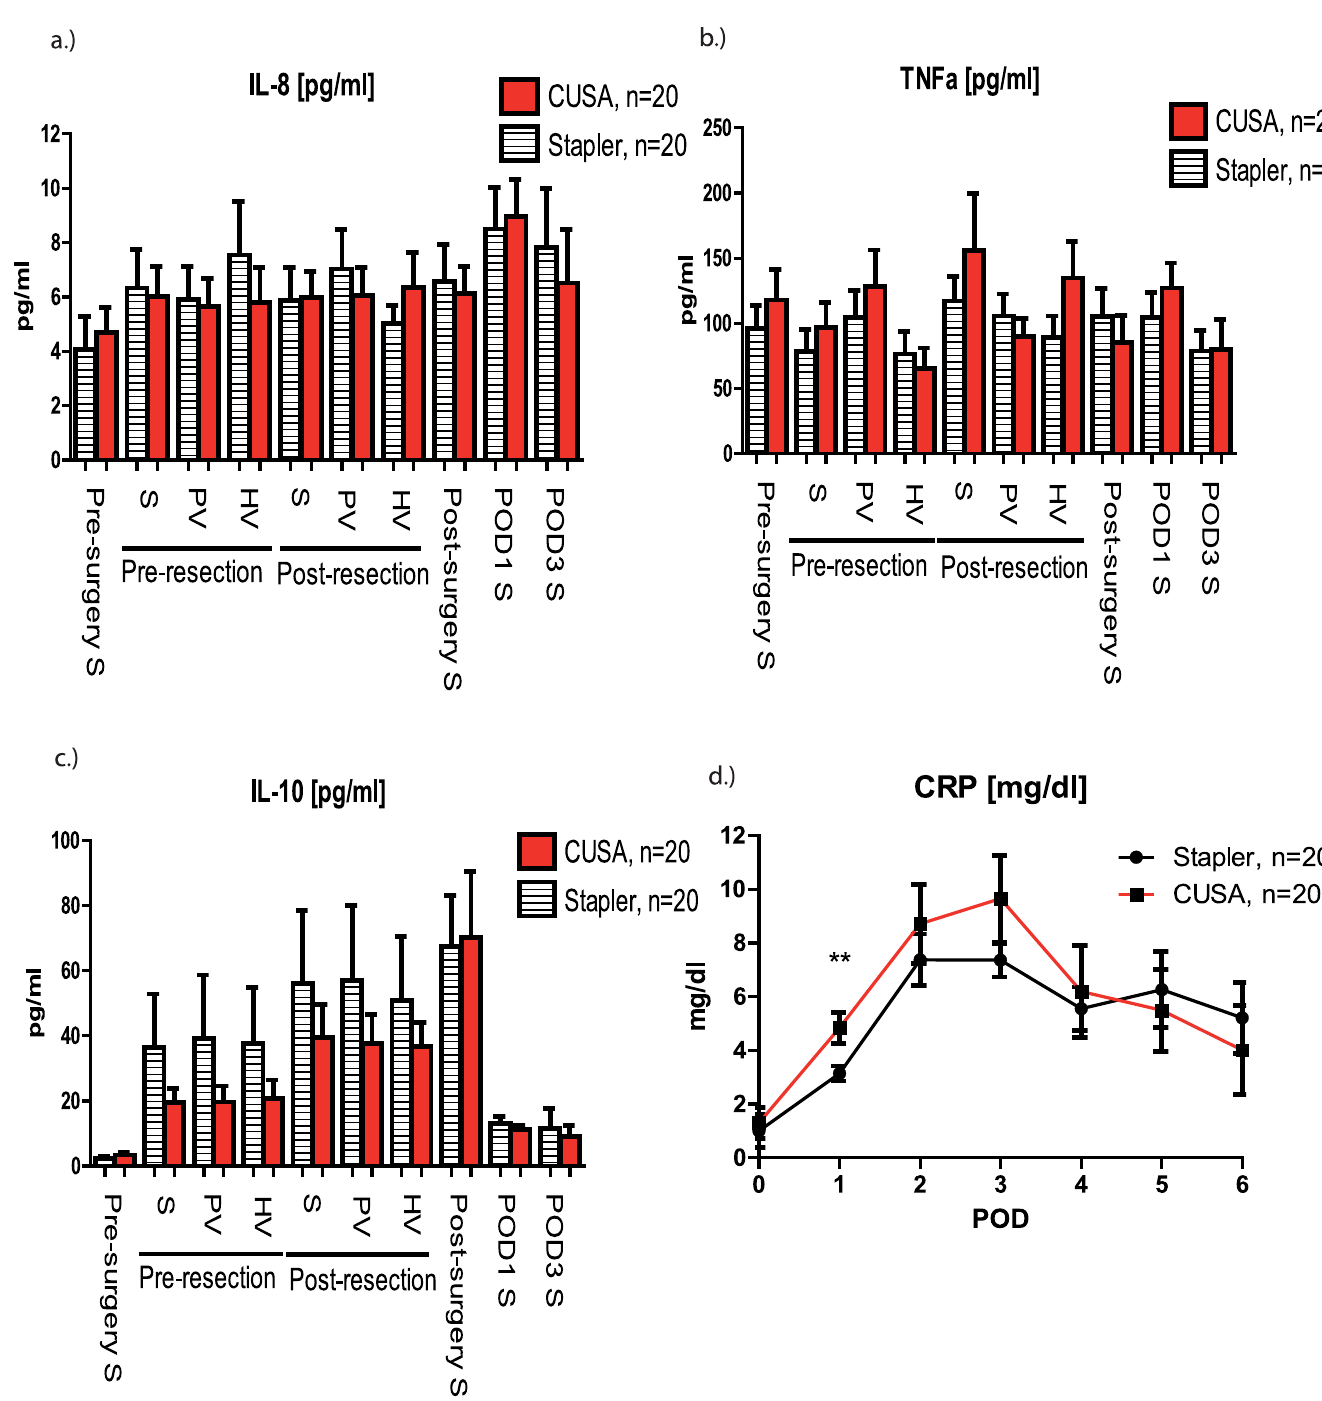
Fig 4. Perioperative course of IL-8, TNFa, IL-10 and C-reactive protein (CRP). There was no significant difference between both groups in perioperative IL-8 (A) , TNFa (B) or IL-10 (C) levels. CRP measured on the first postoperative day (POD) was significantly higher in patients undergoing CUSA resection than in patients with stapler hepatectomy (3.1 (0.3) vs. 4.8 (0.5); p = 0.010). Graphs show mean values ± SEM.